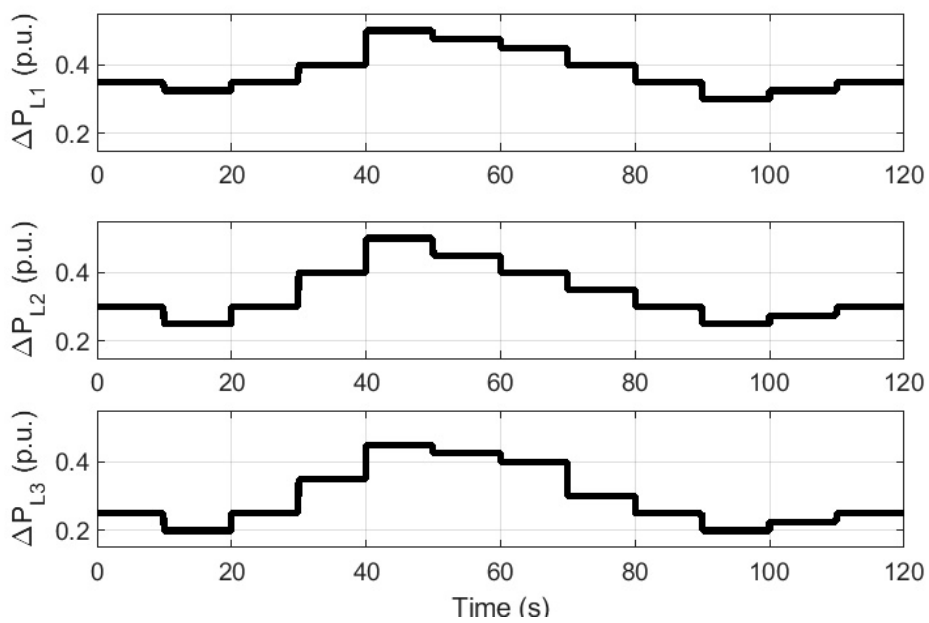
Figure 5. Loading pattern of 3 microgrids considering LL.